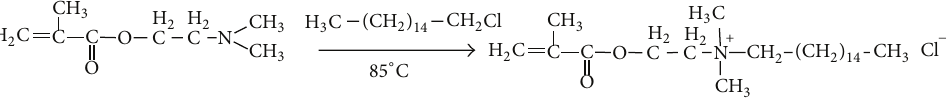
Scheme 1: Synthesis of the cationic surfmer